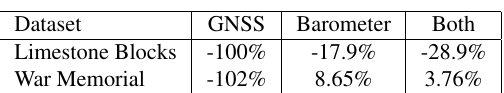
Table 6: Percentage error for each set of